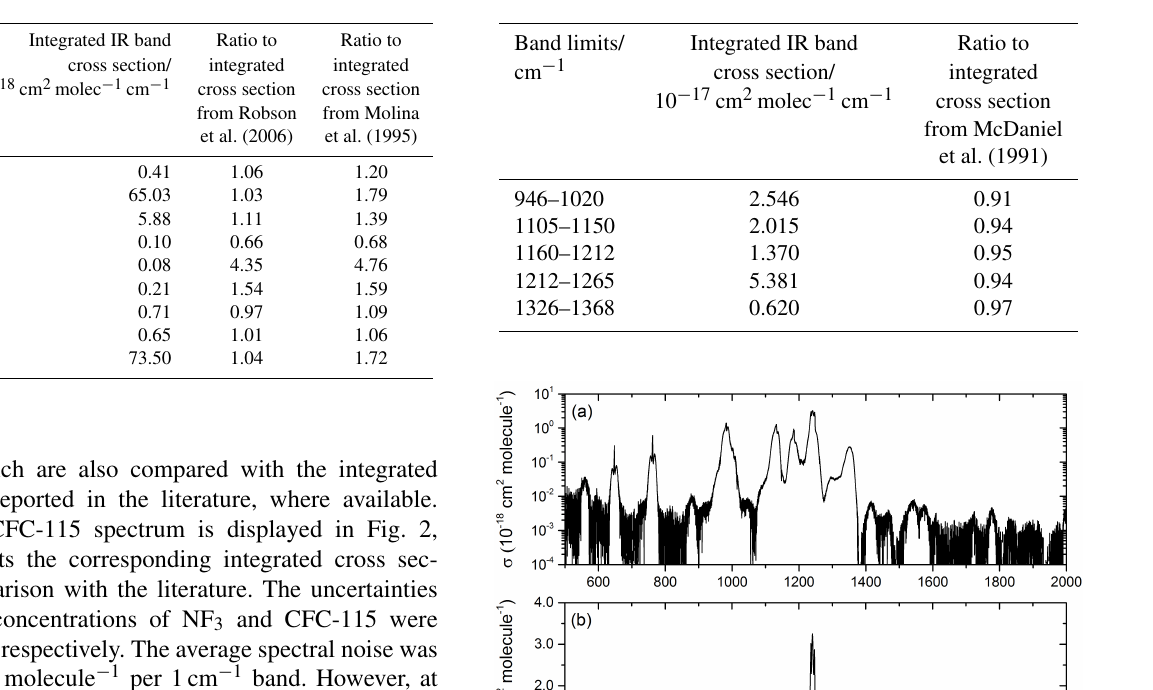
Table 3. Integrated absorption cross sections of CFC-115 measured in the present study at 296 ± 2K (1 σ uncertainty ± 6% for the ma- jor bands), and compared to the previous study of McDaniel et al. (1991).